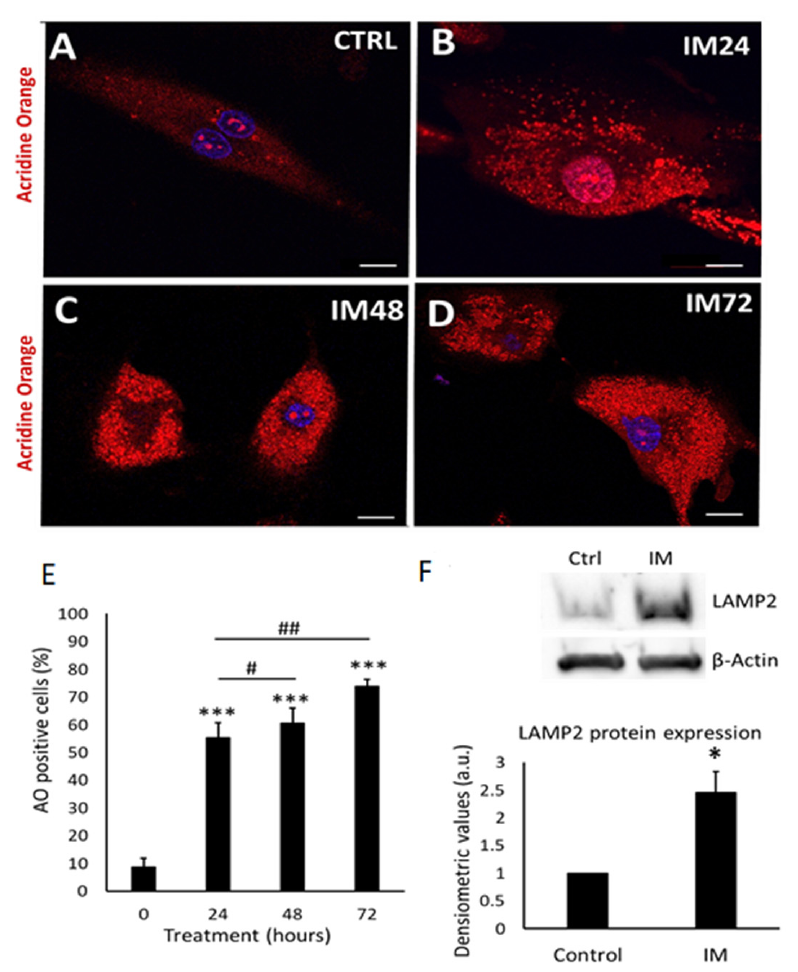
Figure 3. IM induces accumulation of acidic vesicle organelles, indicative of autophagy and LAMP2 expression. ( A – D ) Representative images of hCPCs stained with acridine orange; orange staining represents acidic organelles: control cells and IM (10 µ M) for 24, 48, and 72 h treatments. ( E ) Quantification of acridine orange staining in hCPCs after IM treatment (10 µ M) relative to control. Data are mean ± SEM for percentage of acridine-orange-positive cells, n = 7. ( F ) Western blot image for LAMP2, control cells, and IM-treatment for 24 h; beta-actin represents loading control. Densitometry for LAMP2 Western blots average signal intensity normalised against control. Data are mean fold change ± SEM, n = 3; * p < 0.05 and *** p < 0.001 vs. control; # p < 0.05 and ## p < 0.01 vs. IM 24 h. Scale bars = 20 µm.